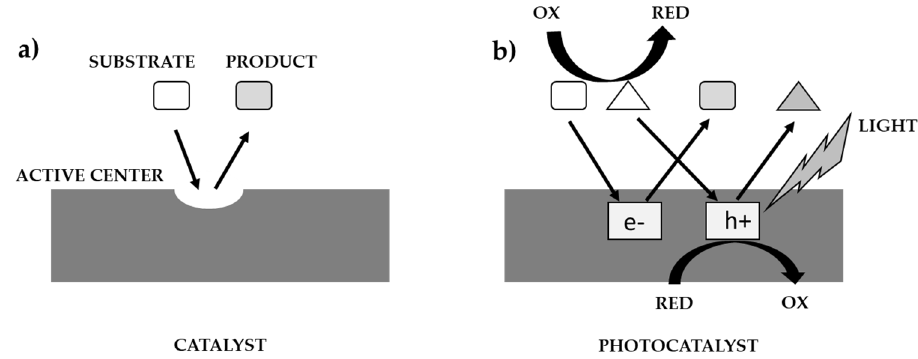
Figure 2. Comparison of catalysis process ( a ) with photocatalysis ( b ) [10].